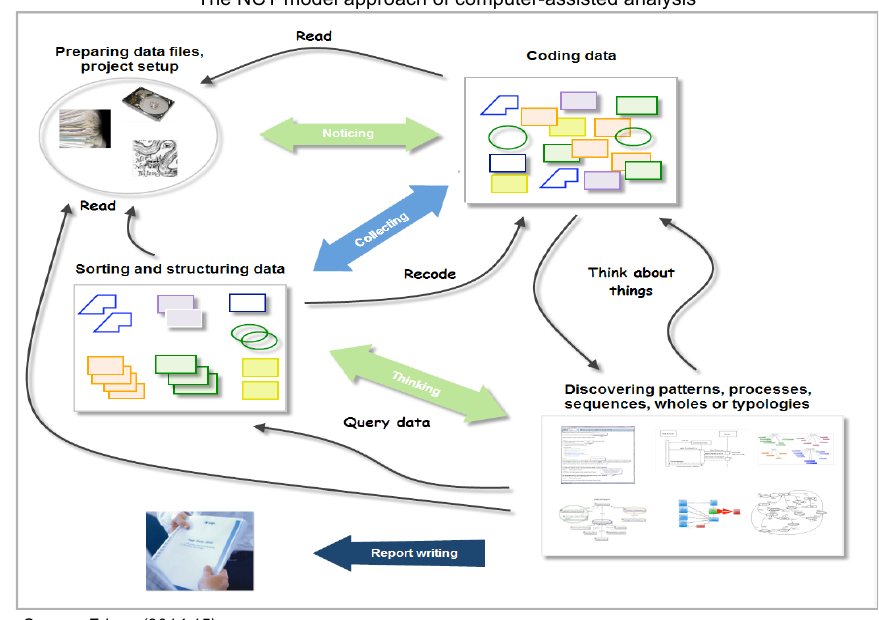
The NCT model approach of computer-assisted